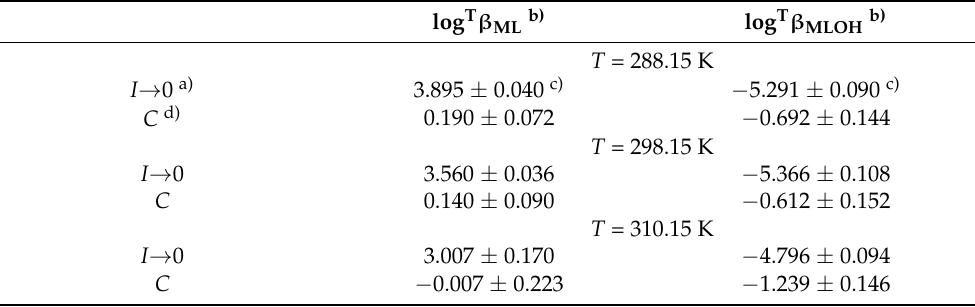
Table 8. Formation constants at infinite dilution and different temperatures of the Mg 2+ /Dop − species.